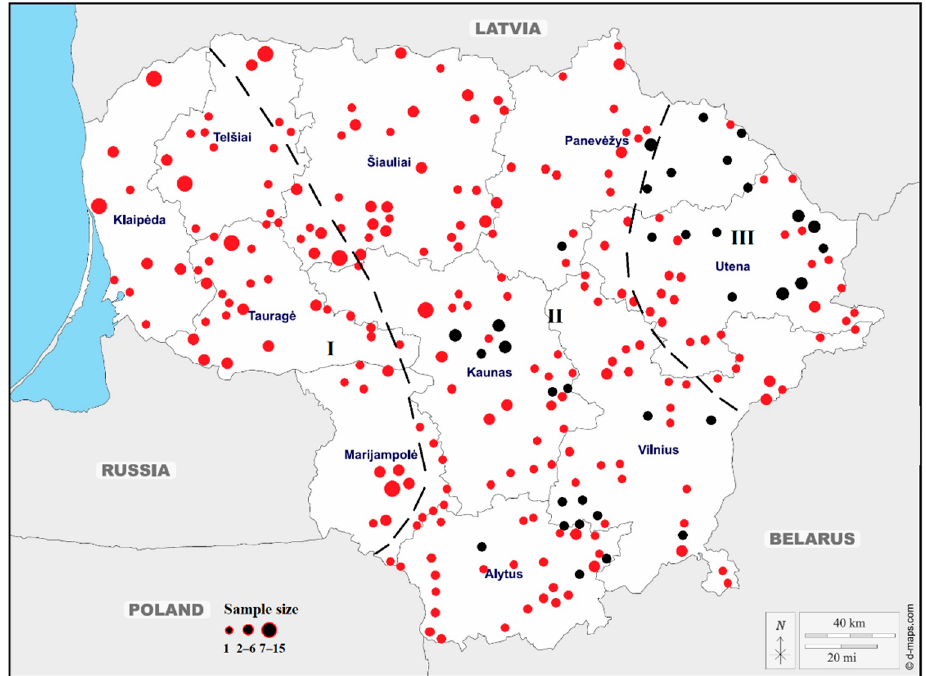
Figure 1. Geographic distribution of sampling sites across Lithuania. Black and red dots show collecting sampling sites of wild boars in 2014–2016 and 2017–2019, respectively. Black dashed lines indicate the restricted zones of African swine fever in Lithuania.